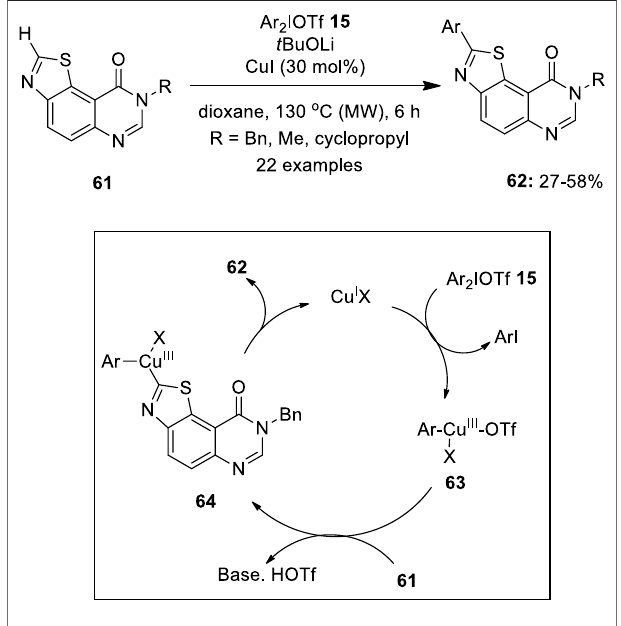
FIGURE 10 | Copper-catalyzed C – H/N − H arylation of indoles 49 with diaryliodonium salts 65 as an aryl source.